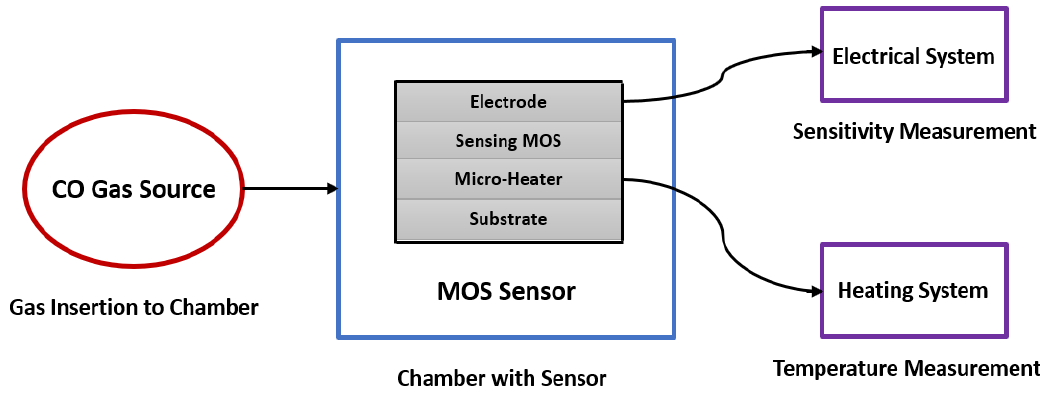
Figure 6. Basic block diagram of MOS thin film-based CO gas detection system.